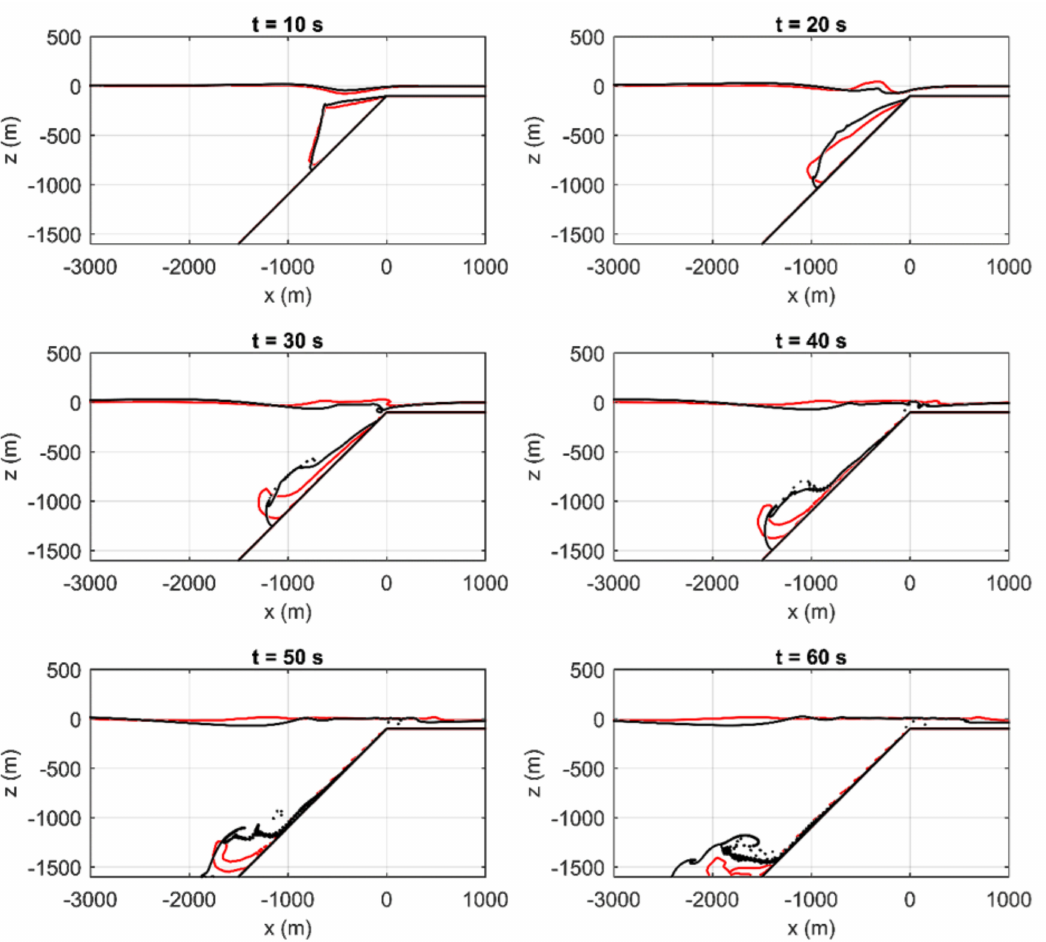
Figure 14. The snapshots of the profiles of free-surface elevation and slump shape of scale H 4 in 2D simulation (black lines) and 3D simulation (red